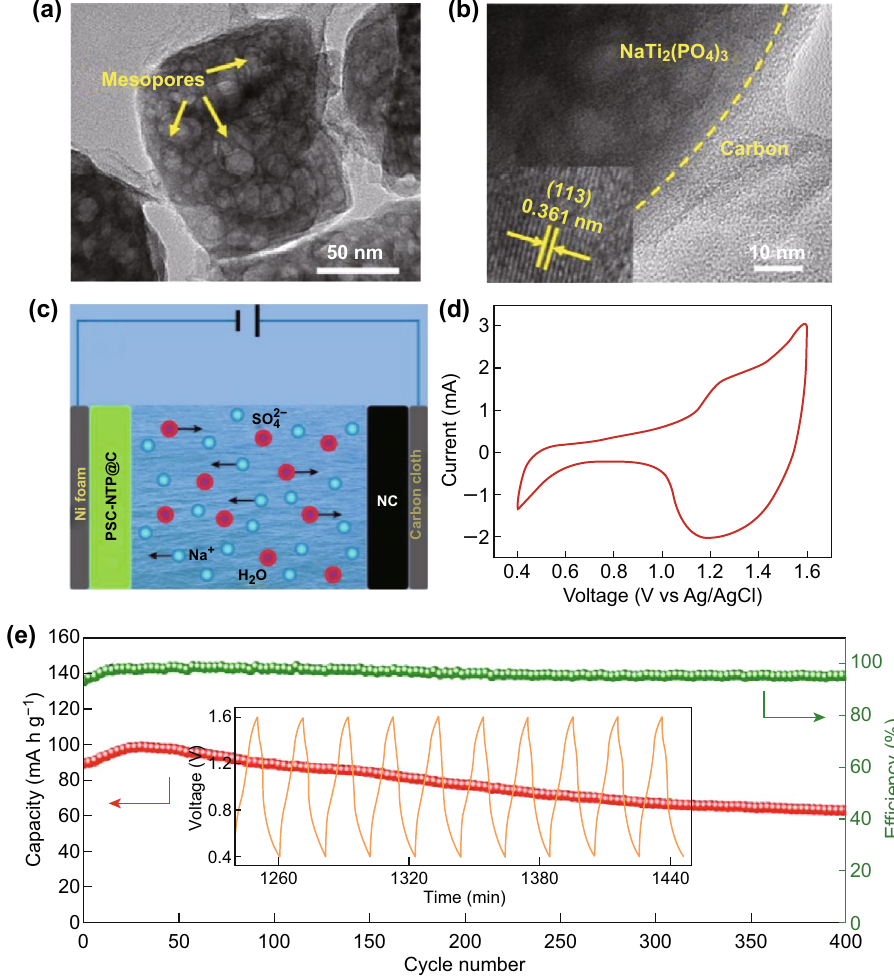
Fig. 15 a TEM image reveals the porous nanostructure of single-crystal NaTi 2 (PO 4 ) 3 coated with amorphous carbon layer (PSC-NTP@C); b HRTEM image at the interface between an NTP and the carbon layer. c Schematic illustration of the PSC-NTP@C//NC Na-ion capacitor in liq- uid aqueous electrolyte; d CV curve of this Na-ion capacitor recorded at 3 mV s −1 within a cutoff voltage window of 0.4–1.6 V. e Cycle perfor- mance of the PSC-NTP@C//NC system at 0.5 A g −1 (the inset shows the voltage–time profile) [38]. Copyright 2018, Elsevier